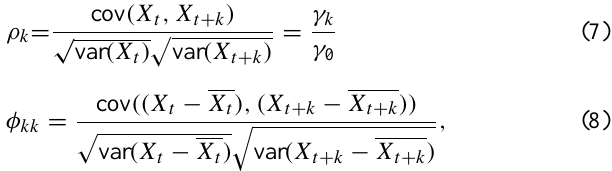
Figure17. Predicted (solid line) and measured (dotted line) (1-B) 2 Tp